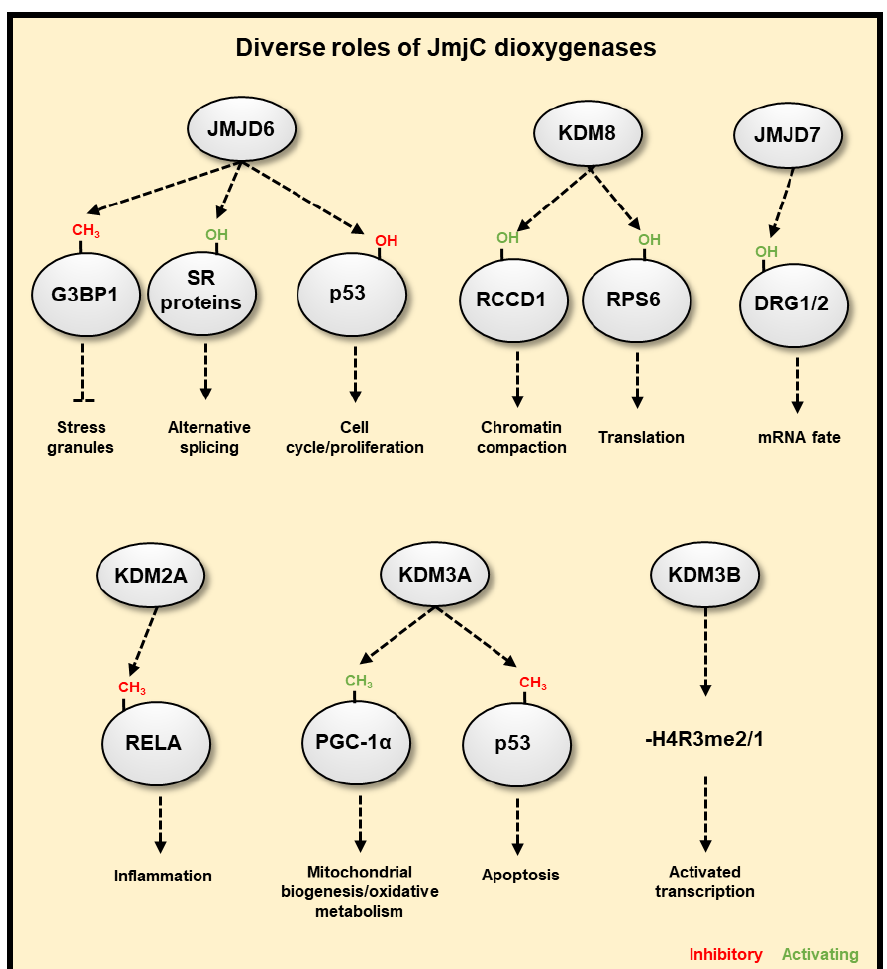
Figure 5. JmjC-domain containing 2OG dioxygenases have diverse cellular functions. JMJD6 is able to promote the formation of stress granules, which reversibly pauses transcript translation through demethylation of G3BP1. JMJD6 can hydroxylate splicing regulatory (SR) proteins, resulting in differential splicing or exon choice, such as skipping the first exon with the hydroxylation of SRSF11. JMJD6 can also hydroxylate p53 repressing its activity. KDM8 is an arginine hydroxylase that can target RCCD1 for chromatin condensation, and RPS6, which affects translation. JMJD7 is a lysyl hydroxylase that can target DRG1/2, affecting their regulation of RNA. KDM2A represses NF-κB activity via demethylation of RELA. KDM3A can demethylate both PGC-1α, promoting mitochondrial biogenesis, and p53, inhibiting its proapoptotic activity. KDM3B is able to demethylate mono- or di-methylated arginine residues, which functions to activate gene transcription.